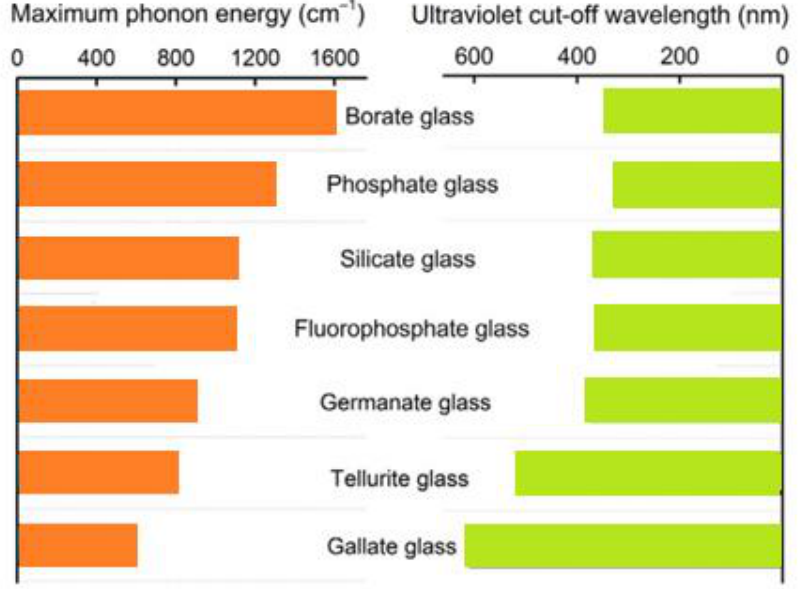
Figure 2. The parallel of highest phonon energy and ultraviolet cut-off wavelength in different glass systems.